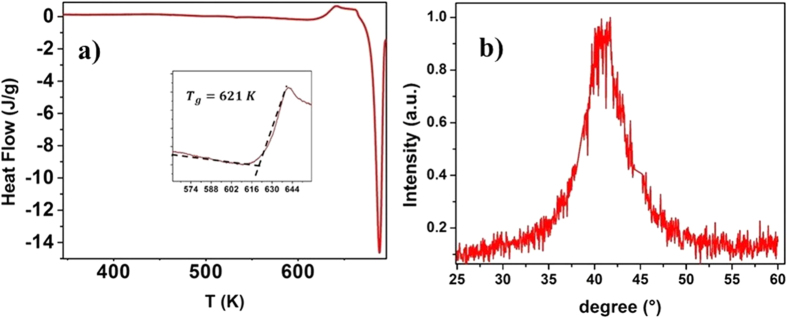
(a) DSC scan of a Pd77.5Cu6Si16.5 Metallic glass sample. (b) and X-ray Difraction pattern of a Pd77.5Cu6Si16.5 sample.